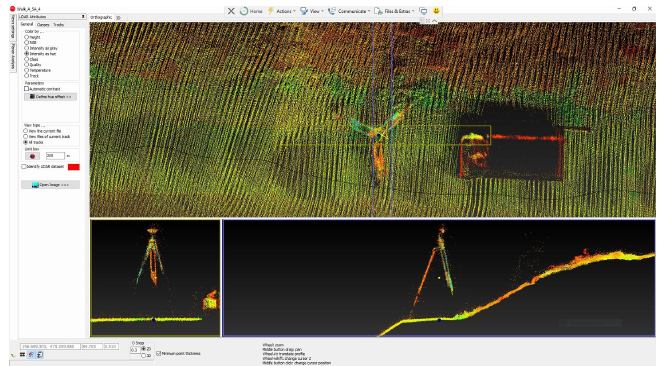
Figure 36. Check the adjusted GCPs over the point cloud.